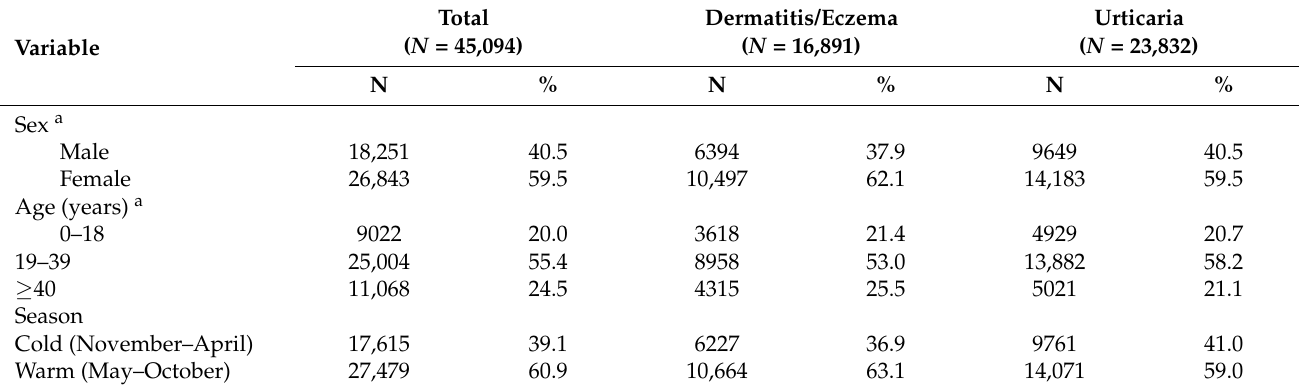
Table 1. Demographic characteristics of patients included in this study, 2014–2019.